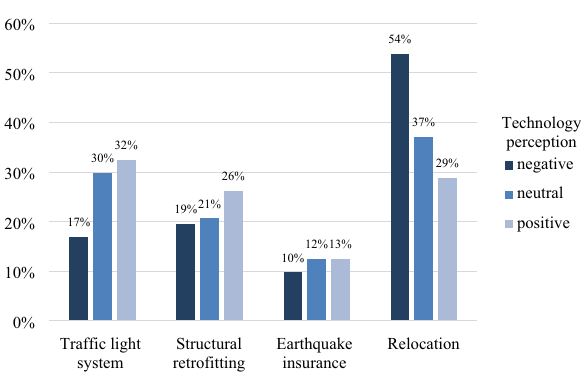
Fig. 3 Risk mitigation preference across technology